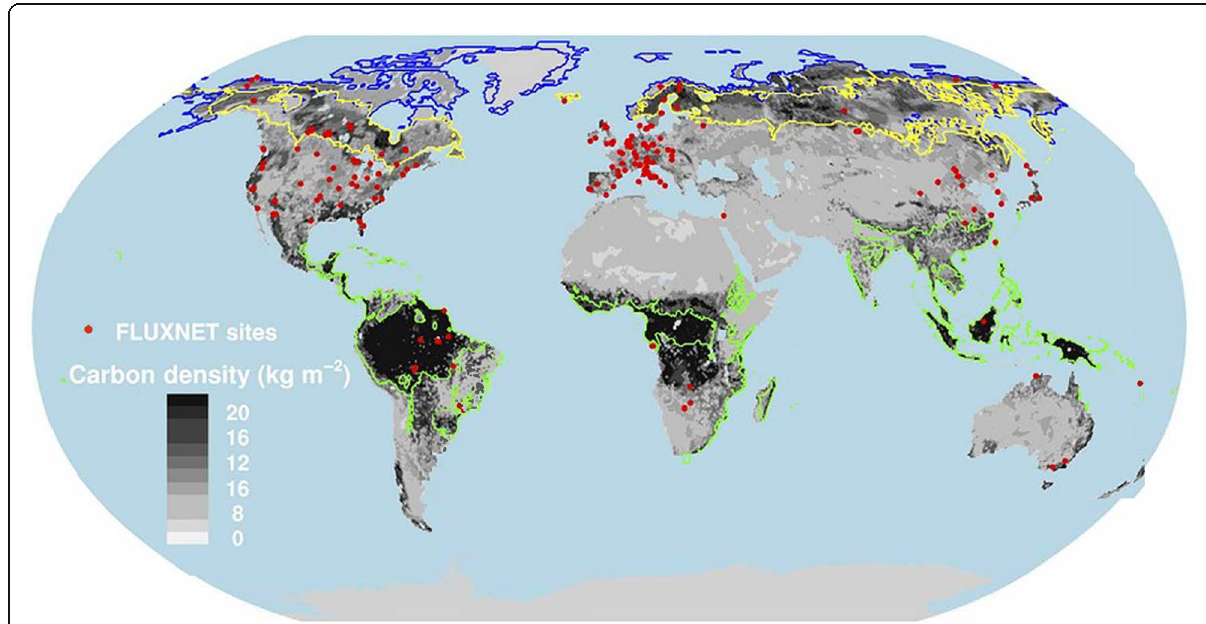
Fig. 14 Climate tipping elements occur where biomass storage is high and at risk for large losses due to climate change (Lenton et al. 2008). Three climate tipping elements are shown in blue (frozen regions), green (tropical forests), and yellow (boreal forests) overlayed on a map of terrestrial vegetation and soil carbon storage. The Red dots indicate flux tower locations, which are largely located outside of the tipping element regions, illustrating the need for satellite measurements to fill gaps in ground sampling. Original figure from Schimel et al. 2014; data from Ruesch and Gibbs (2008) and FAO et al.